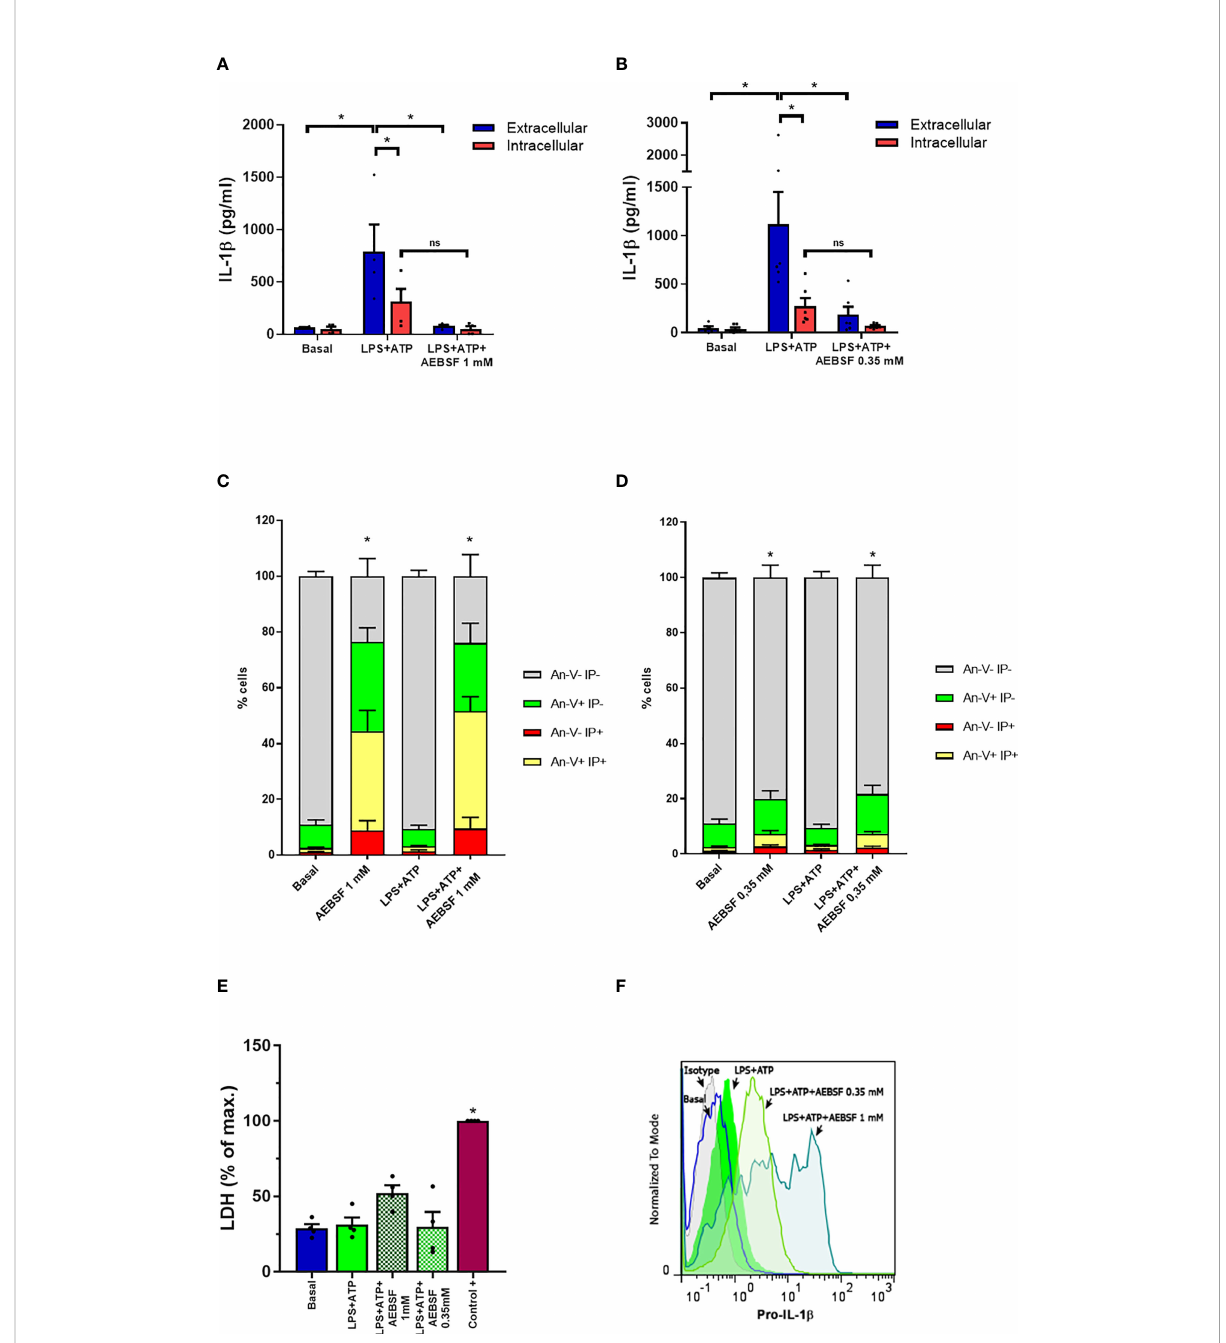
FIGURE 1 Treatment of neutrophils with the NSPs inhibitor AEBSF reduces IL-1 b secretion without compromising pro-IL-1 b synthesis. (A, B) Extracellular (blue bars) and intracellular (red bars) concentrations of IL-1 b in culture supernatants of unstimulated (basal) or LPS + ATP-stimulated neutrophils for 5 h in the absence or presence of AEBSF added 30 min before LPS stimulation. Data represent the mean ± SEM of experiments performed in triplicate with 4 donors. (C, D) Apoptosis evaluated by annexin V-PI staining and fl ow cytometry in the cell pellets of the same donors evaluated in (A) and (B) . (E) LDH levels determined in culture supernatants of neutrophils treated as indicated and expressed as % of maximal LDH content, represented by the amount of LDH of a whole extract of the same number of neutrophils employed in the assay (control+). Data represent the mean ± SEM of experiments performed with 4 donors. (F) Pro-IL-1 b expression in neutrophils stimulated or not with LPS+ATP (2.5 h p.s.) and pretreated or not with AEBSF (0.35 or 1 mM) evaluated by immunostaining and fl ow cytometry. Histograms are representative of experiments with 4 donors. *p<0.05. Two-way ANOVA followed by Bonferroni ’ s multiple comparisons test. ns, non-signi fi